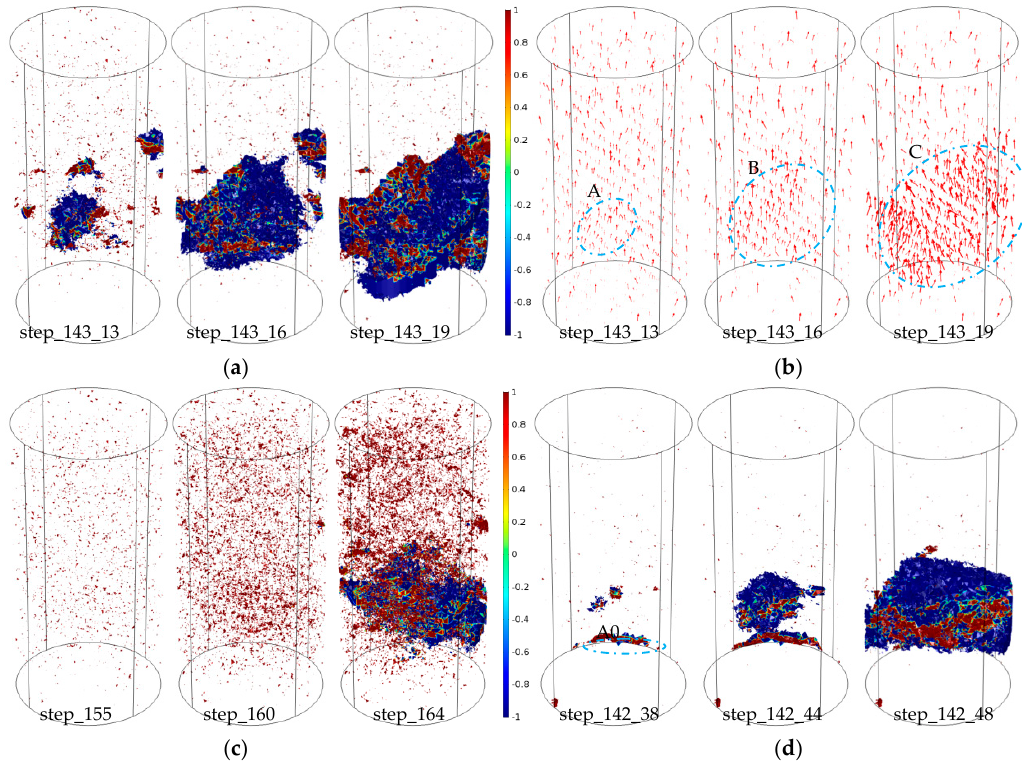
Figure 6. Progress of damage and flow field under different heterogeneity degrees: ( a ) Damage with m = 6; ( b ) Flow field with m = 6; ( c ) Damage with m = 3; ( d ) Damage with m = 9.